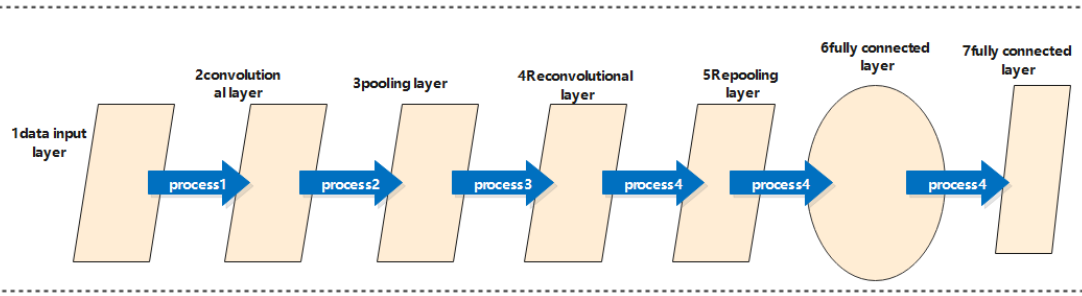
Figure 10. Model diagram of the output process of the two-dimensional convolutional layer.